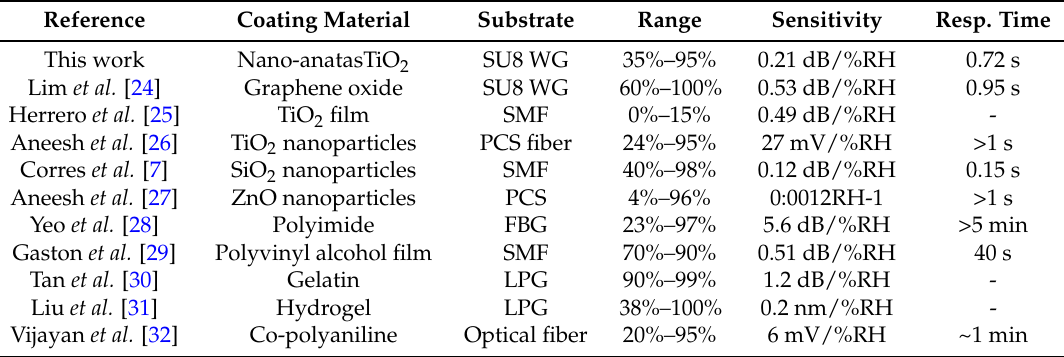
Table 2. Comparison of reported sensor with other proposed sensors using different coatings and